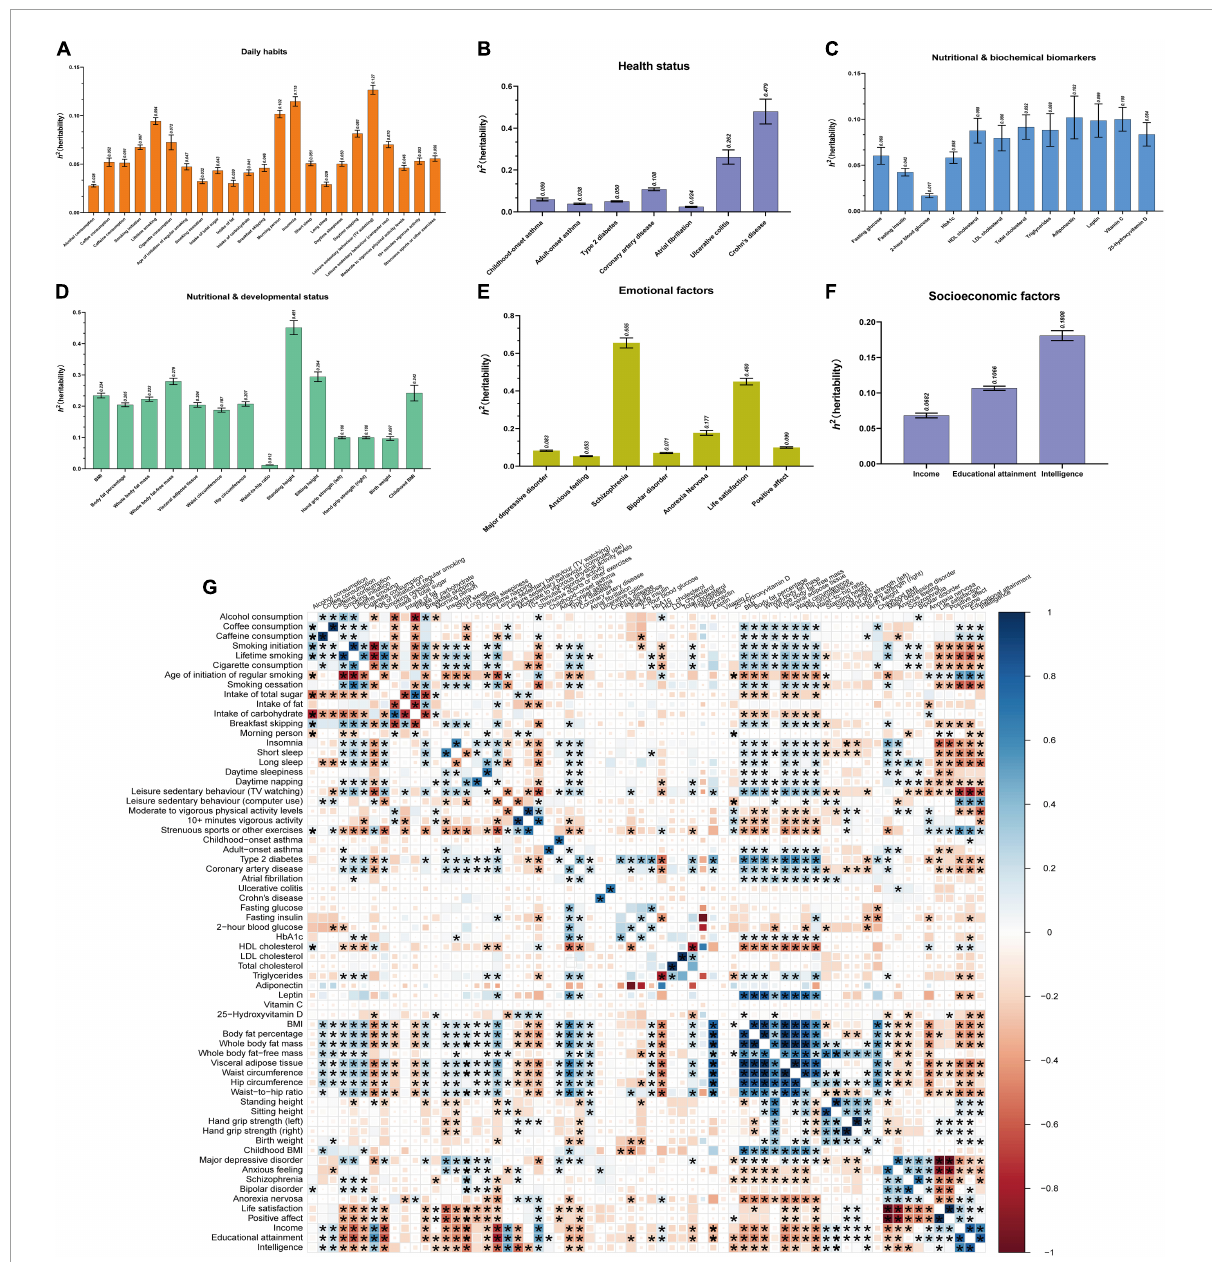
FIGURE3 Estimations of heritability and genetic correlations for 66 exposures using LDSC. (A–F) Estimations of heritability for 66 exposures across 6 modifiable pathways (daily habits, health status, nutritional and biochemical biomarkers, nutritional and developmental status, emotional factors, and socioeconomic factors). Mean with SEM was represented with error bar. (G) Genetic correlations between 66 exposures. Totally, there were 2,145 (66 exposures*32.5) genetic correlations among 66 exposures. The sizes and colors of squares respectively represented the significance level and genetic correlation directions. If P ≤ 0.05 (the threshold of genetic correlation with statistical significance), the squares would be full-sized. P ≤ 2.331E-05 (0.05/2145, Bonferroni multiple comparisons) was considered as the threshold of genetic correlation with significantly statistical significance between two exposures, whose squares would be showed with